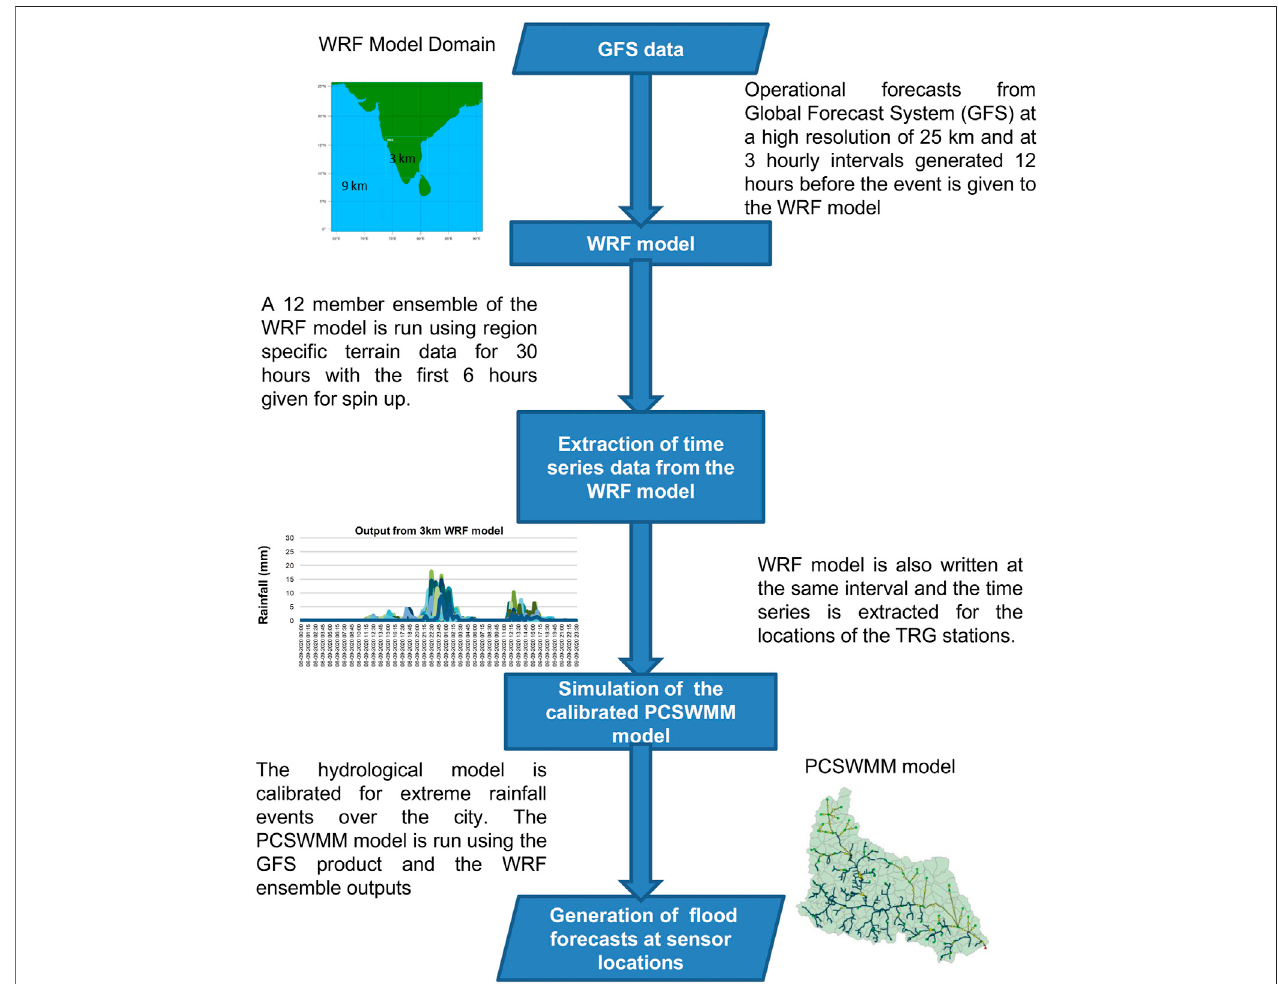
FIGURE2| Flowchartrepresentingthemethodology ofcoupling ofthe atmospheric and hydrologic model. Operational GFSdataisused toruntheWRF modelto generate high resolution rainfall forecasts. The data corresponding to the locations of the observed network is extracted and given as an input to the PCSWMM fl ood model to forecast water levels at critical sensor locations.